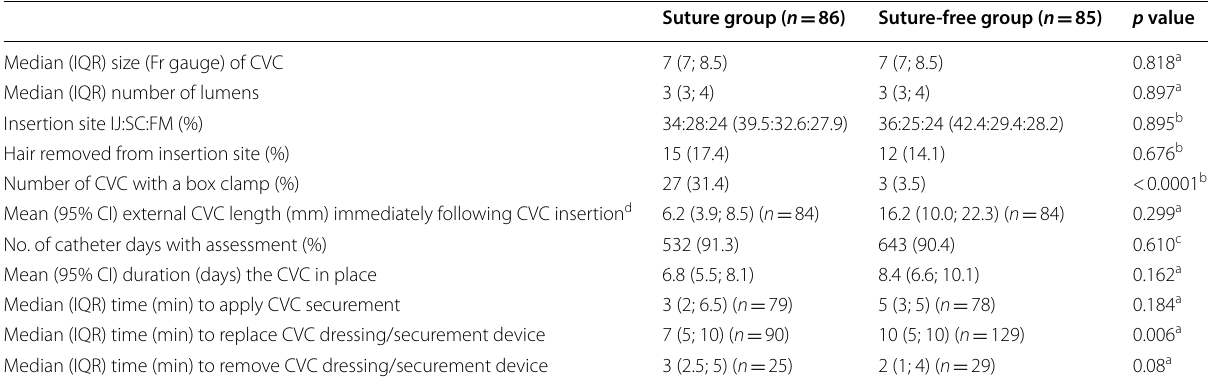
Table 2 Central venous catheter (CVC) and CVC securement characteristics in the two study groups